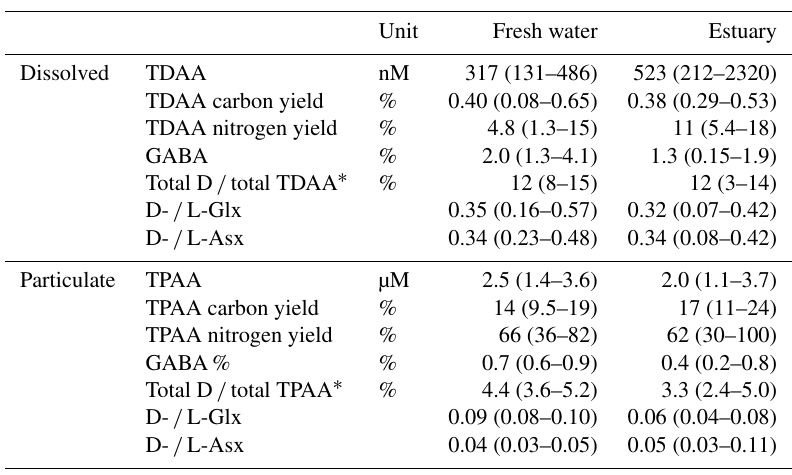
Table 2. Rajang AAs (mean (min–max)) in August